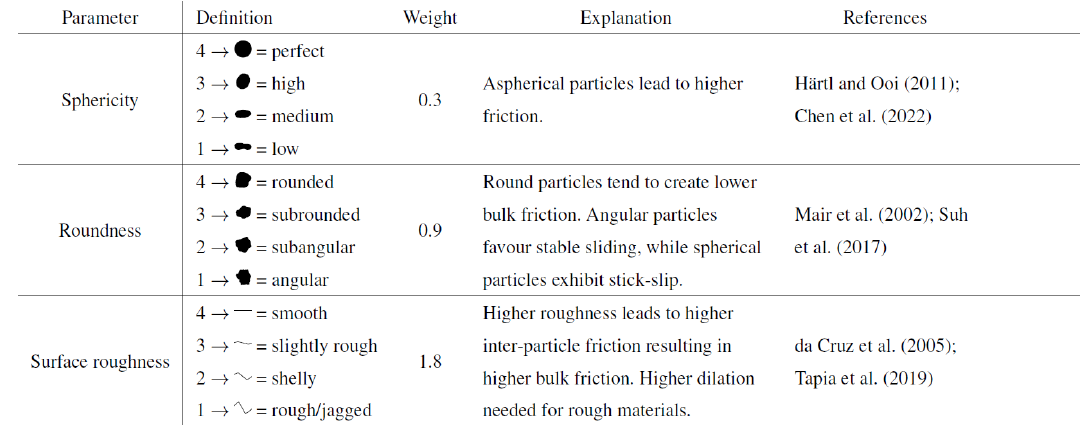
Table 2. Categorisation scheme for granular materials with a simple “quality score”. A lower score indicates a tendency for higher internal friction and time